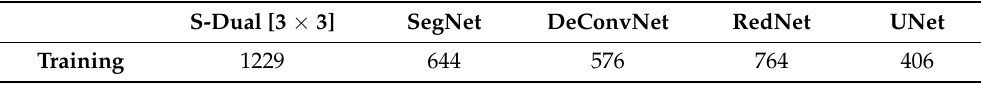
Table 2. Training time (in minutes) comparison between CNN models at 300 epochs. S-Dual [3 × 3] SegNet DeConvNet RedNet UNet